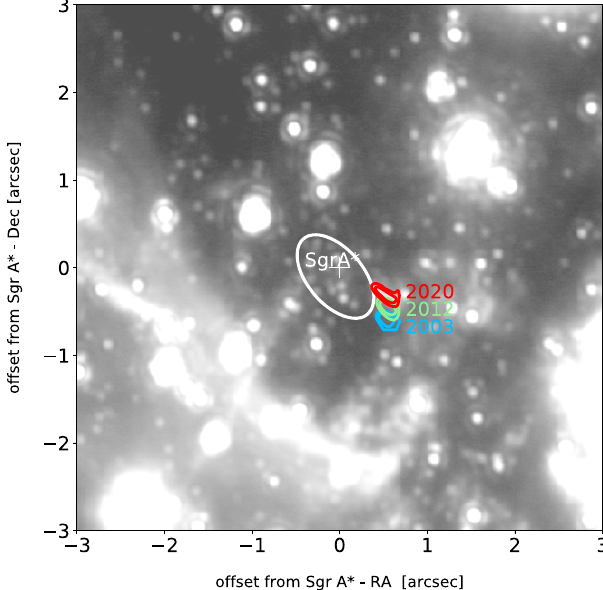
Figure 11. Projected orbit of the X7 tip ( white ) overlaid on a 2020 grayscale Lp image. Contours show the X7 Lp emission at three different epochs, illustrating that X7 is not elongating along its orbital trajectory. X7 orbit is compact and does not overlap with nearby large-scale extended features, such as the mini-spiral, whose northern arm is visible at lower left of the